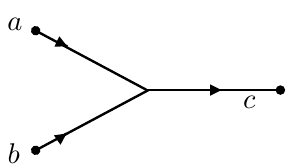
Figure 5 . Fusion of endable lines L a and L b . If L a and L b are both endable, then any line L c with N c 6 = 0 must also be ab